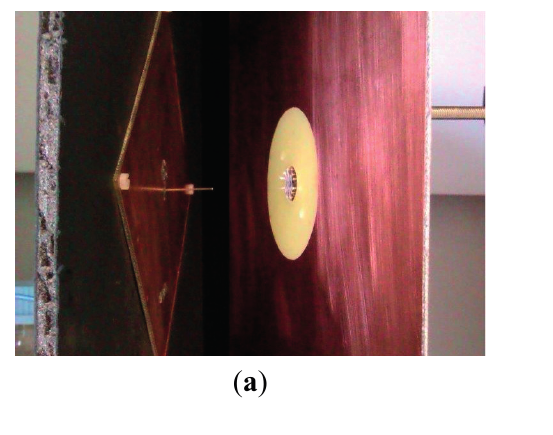
Figure 2. ( a ) Image of the electrodes in the nanofibers deposition: to the left, the source with the needle and the metal screen, both at 18 kV, and in the right part, the focus metal square plate at 1 kV, and the target in its center at 0 V; ( b ) Schematic illustration of the electrospinning